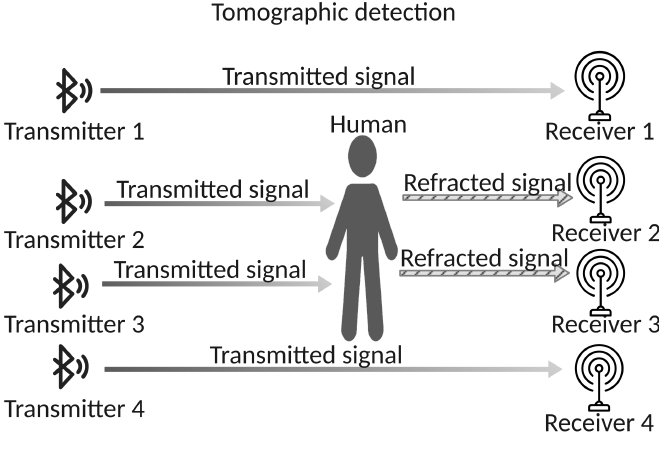
Figure 4. Tomographic